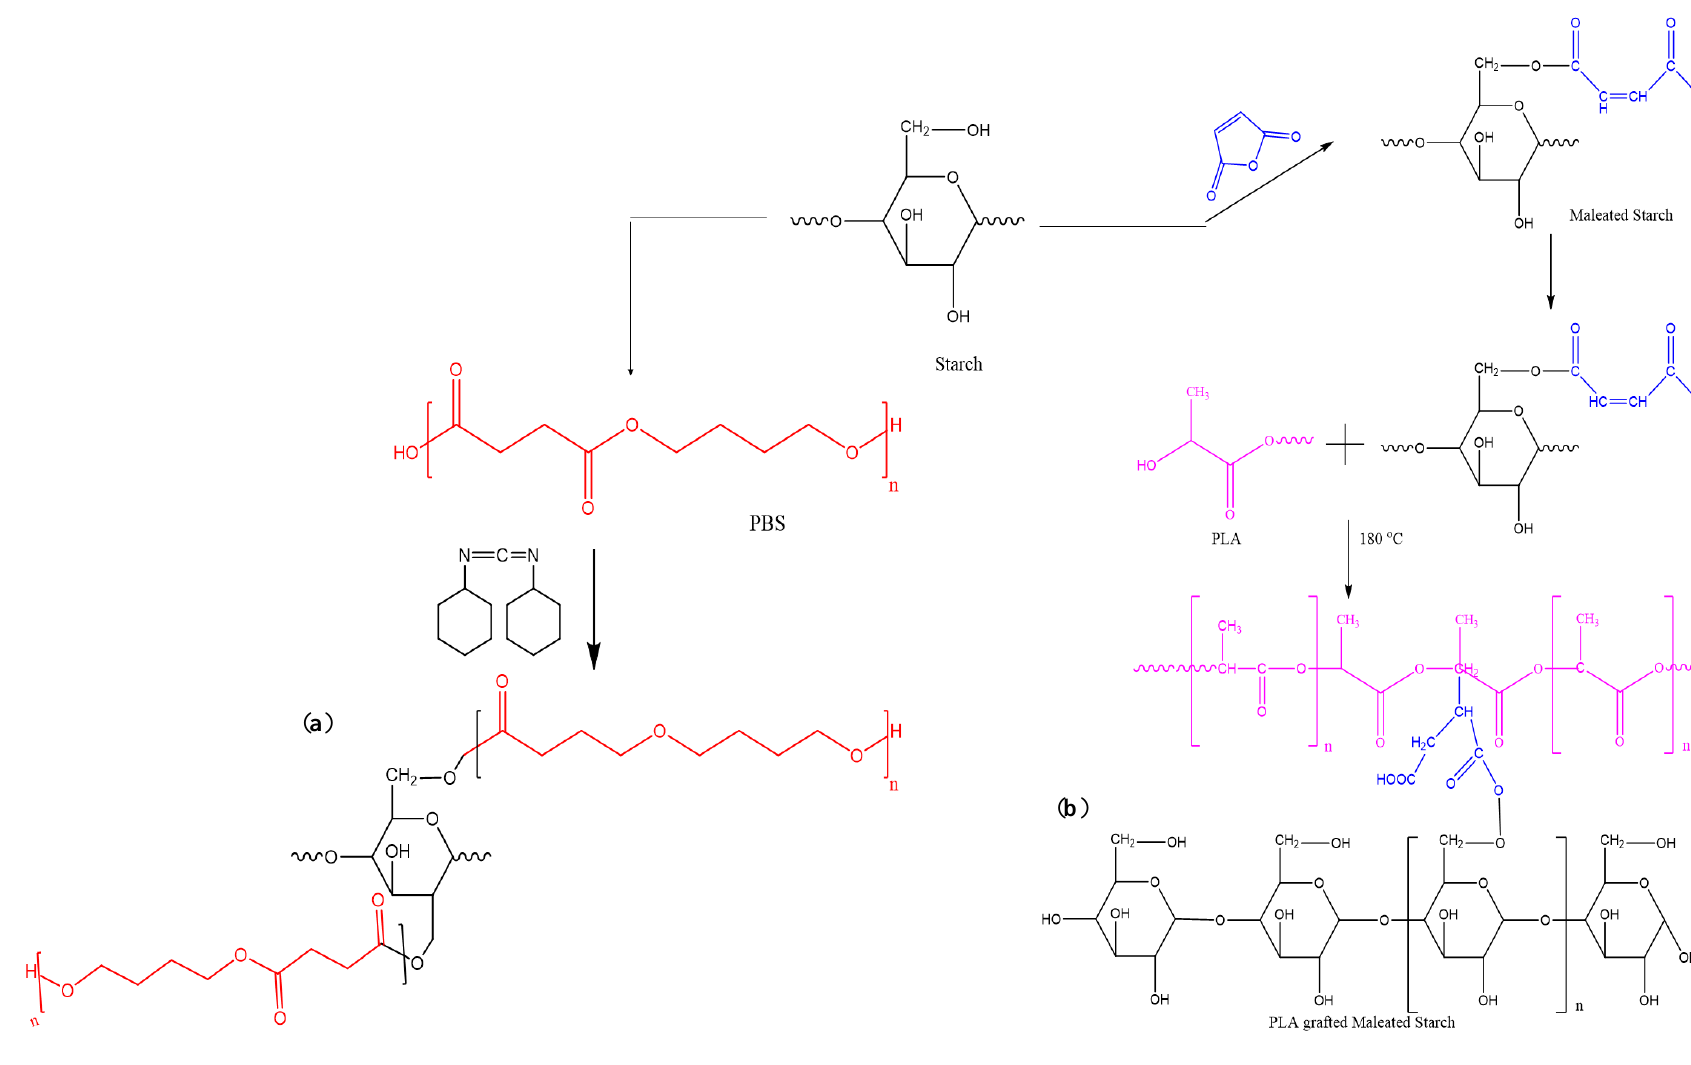
Figure 5. Synthesis route during the preparation of ( a ) Starch-g-PBS ( b ) PLA-g-MTPS.